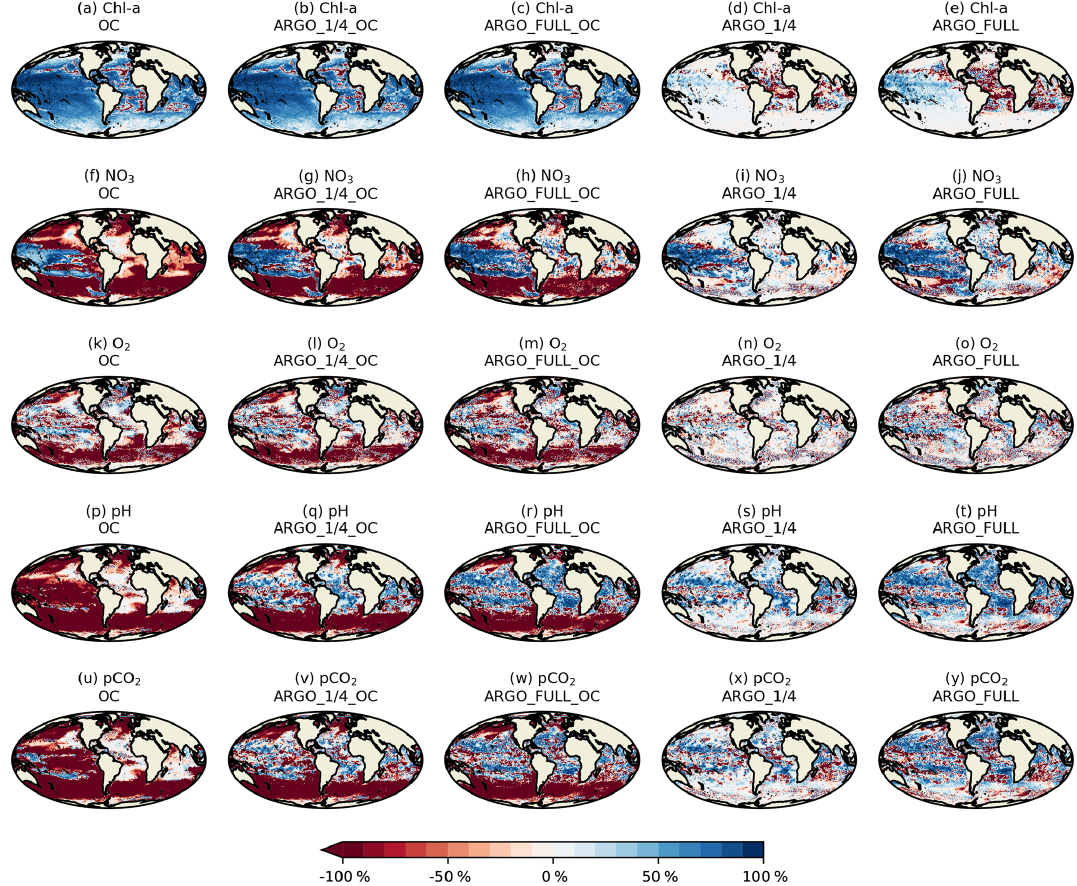
Figure 8. Surface MAE red_% over FREE for Chl a , NO 3 , O 2 , pH, and p CO 2 for December 2009.